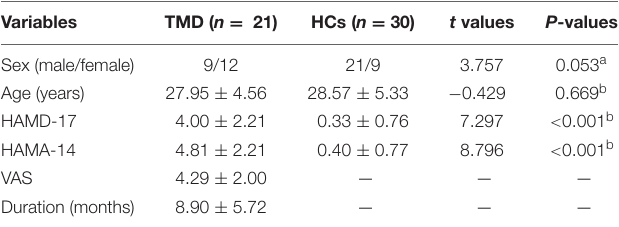
TABLE 1 | Demographic and clinical characteristics of